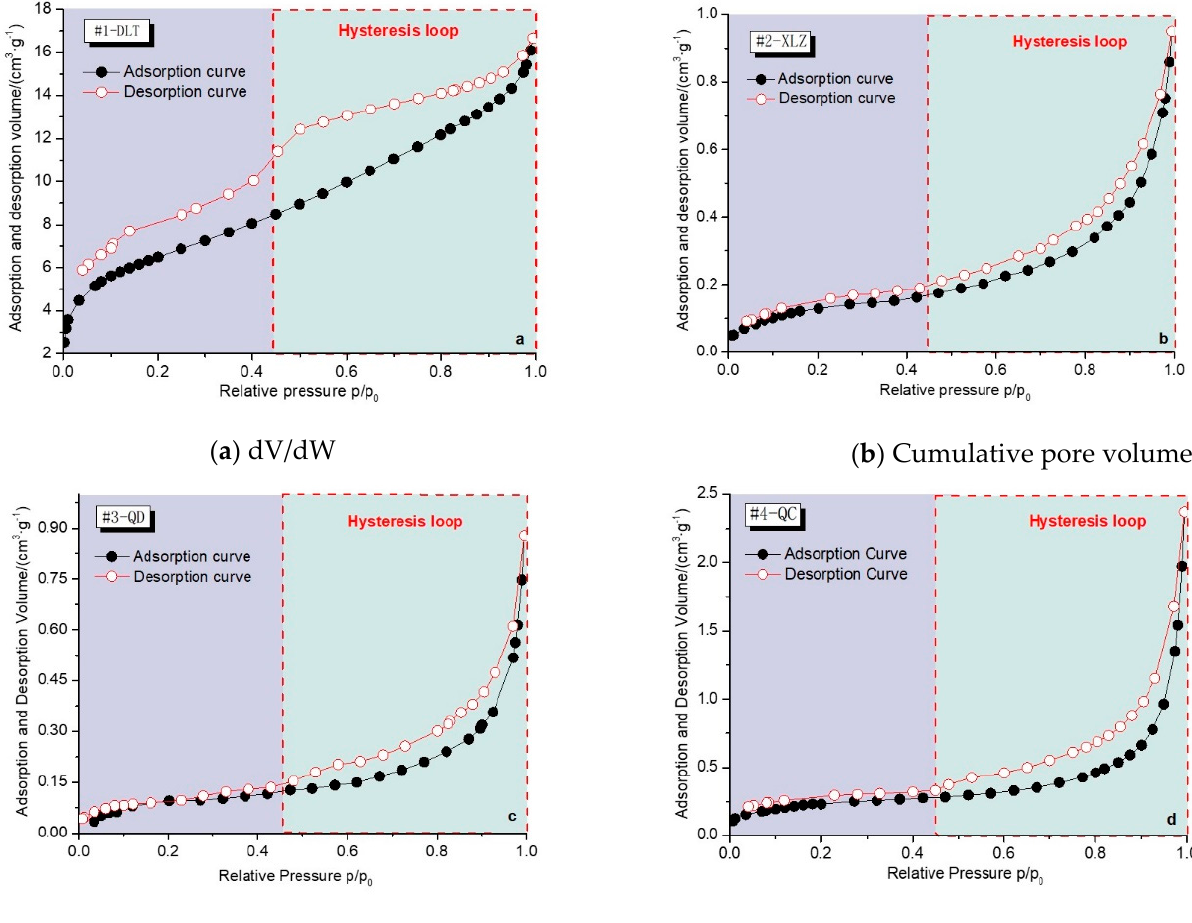
Figure 3. The pore size distribution measured with the NAM.